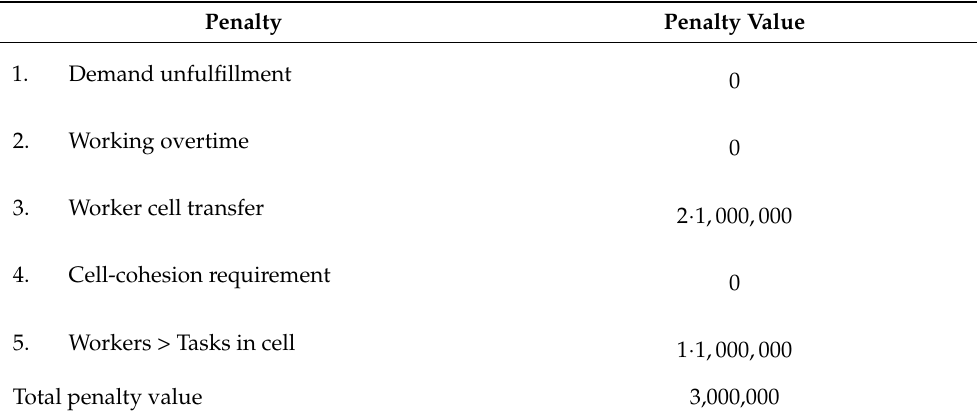
Table 6. Penalty values obtained by using NSGA-II for the illustrative example.